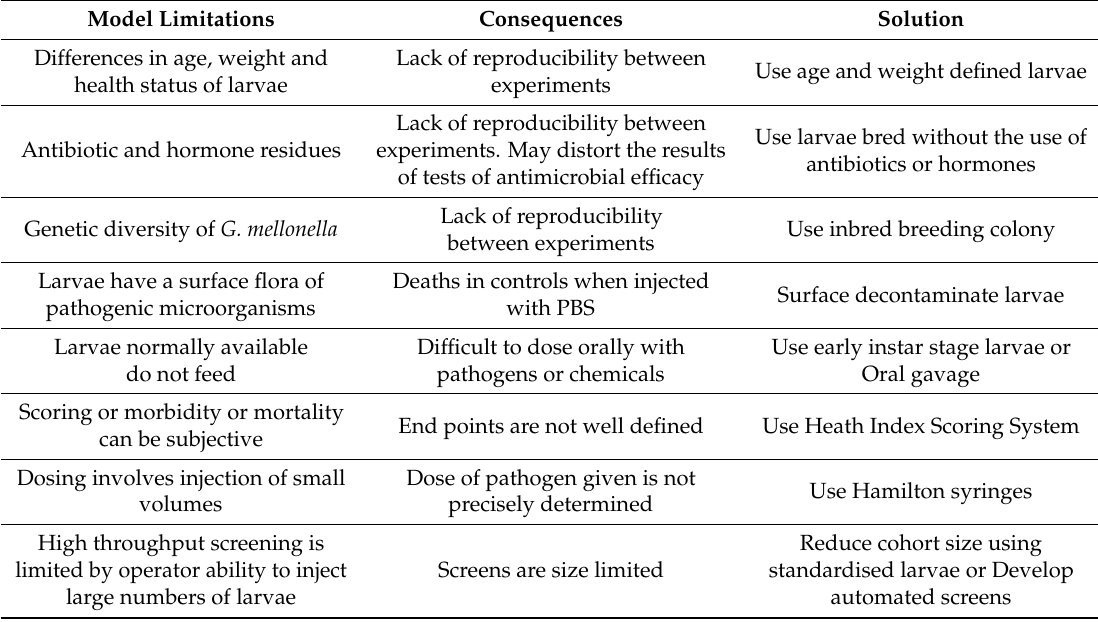
Table 3. Approaches to standardizing experiments using G. mellonella